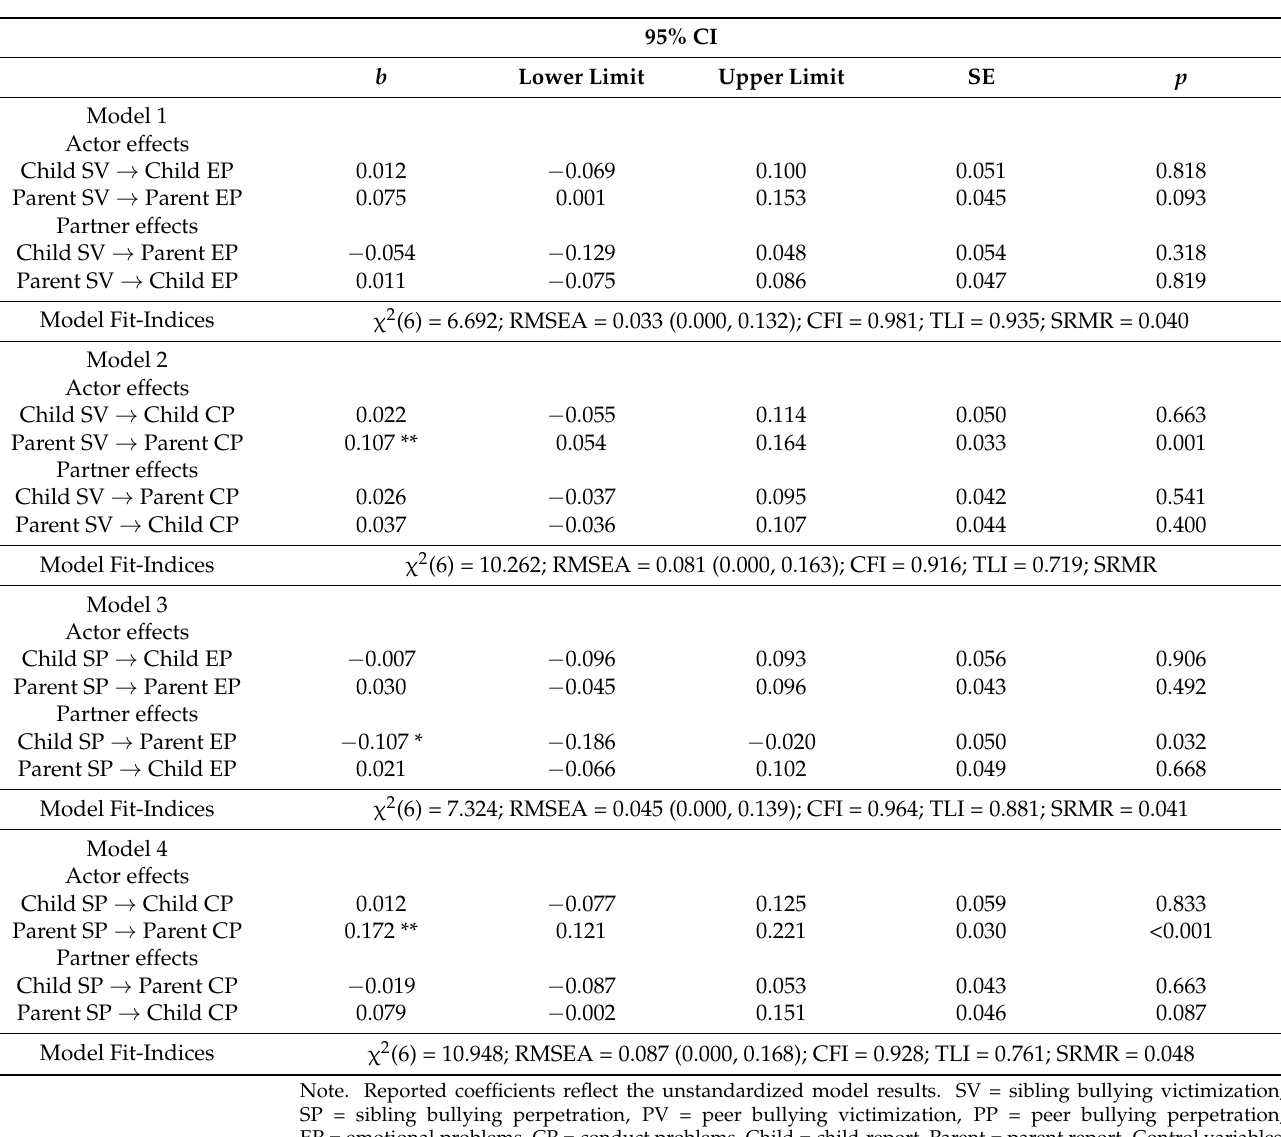
Table 5. Actor-partner interdependence models of child- and parent-reports of sibling bullying and child outcomes ( n =